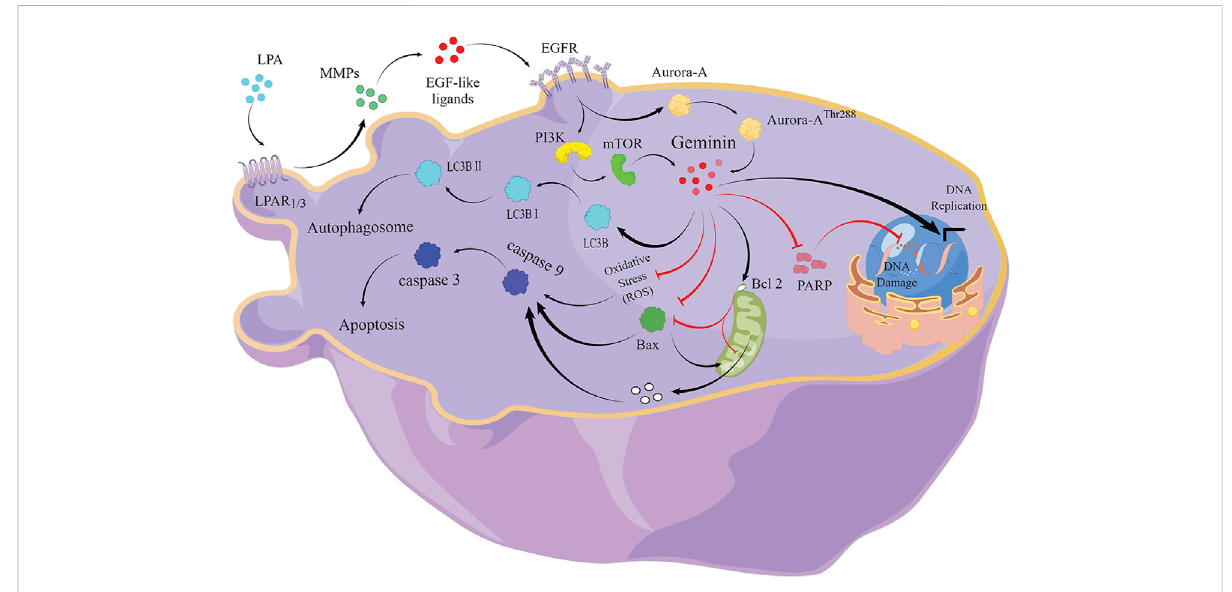
FIGURE 5 The signaling pathway of LPA-mediated DNA replication initiation, cell-cycle progression, and autophagy in HGSOC